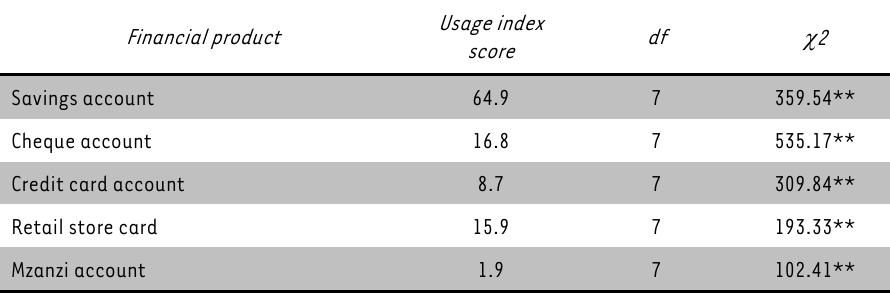
TABLE 3: Cash management products